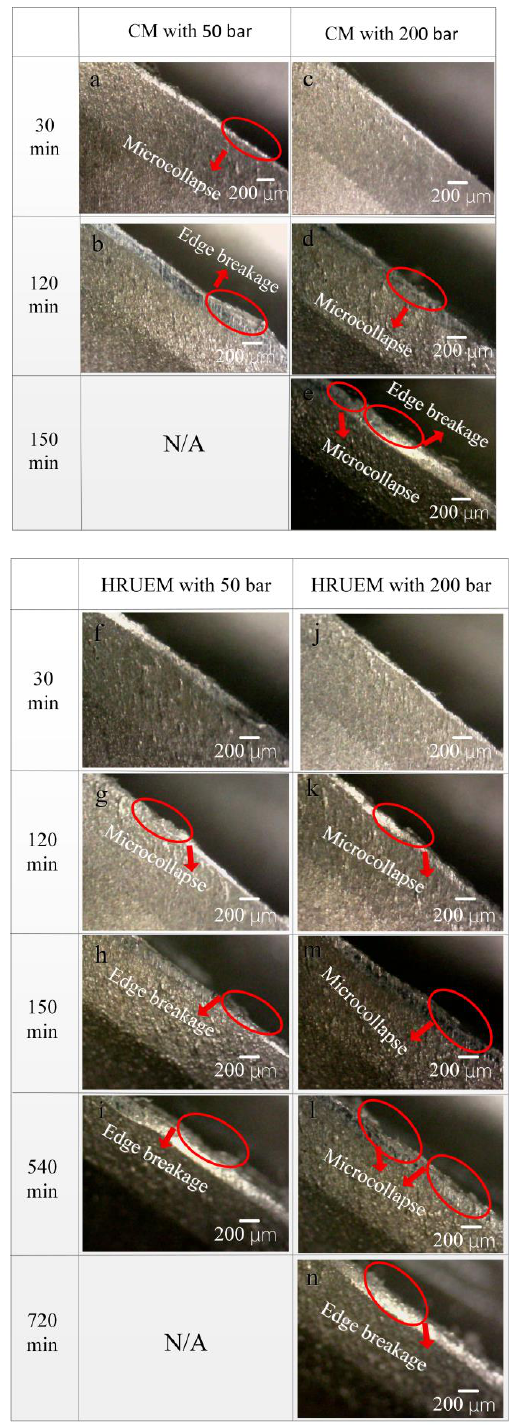
Figure 11. Micrographs of tools in CM and HRUEM with different cooling conditions at cutting speed of 120 m/min: (a) –( b ) CM with 50 bar, ( c )–( e ) CM with 200 bar, ( f )–( i ) HRUEM with 50 bar and ( j )–( n ) HRUEM with 50 bar.